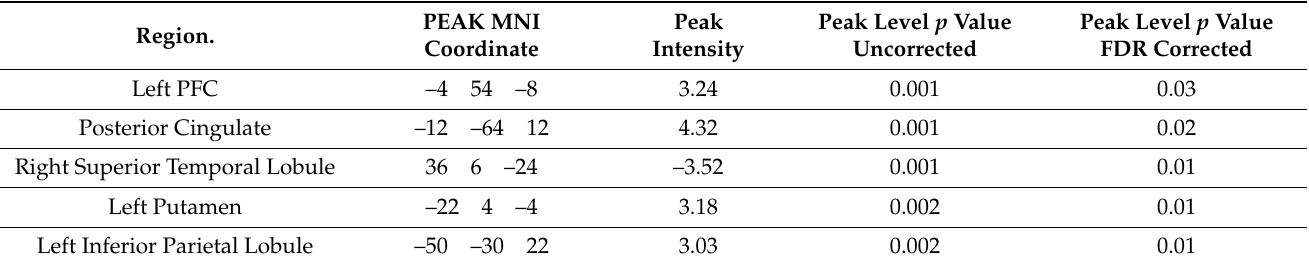
Table 3. Cerebral blood flow differences between the pre- and the post- MBSR program scans during the meditation state (PFC = prefrontal cortex). The peak intensity represents the T statistic at the peak statistical significance for the cluster.